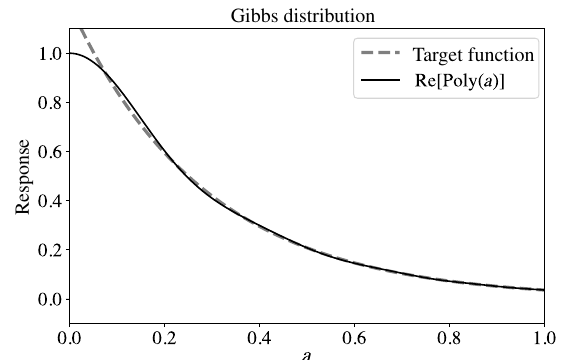
FIG. 30. The response function for the polynomial approxi- mation to the Gibbs distribution for a > 0 with β = 3.5 using a degree- ( d = 20 ) polynomial. The response is scaled to maximize Poly ( a ) . Note that the approximation deviates from the target near a = 0, as the symmetrized version of the Gibbs distribution is nonanalytic about that point.